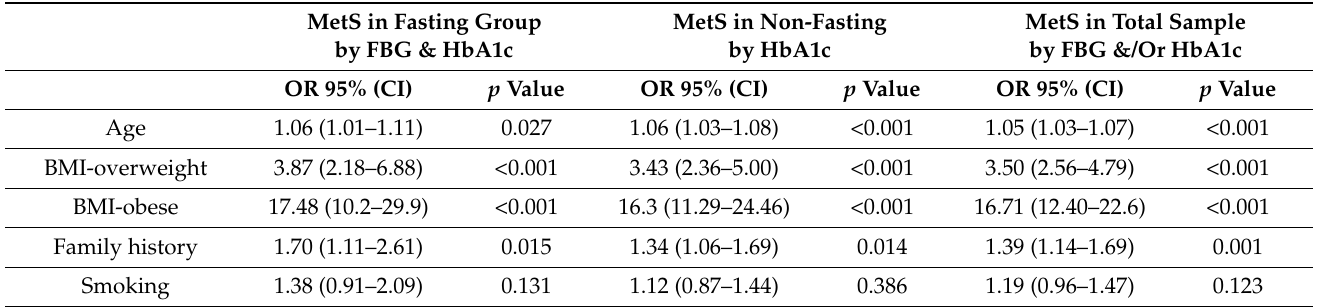
Table 5. Multivariate logistic regression analysis